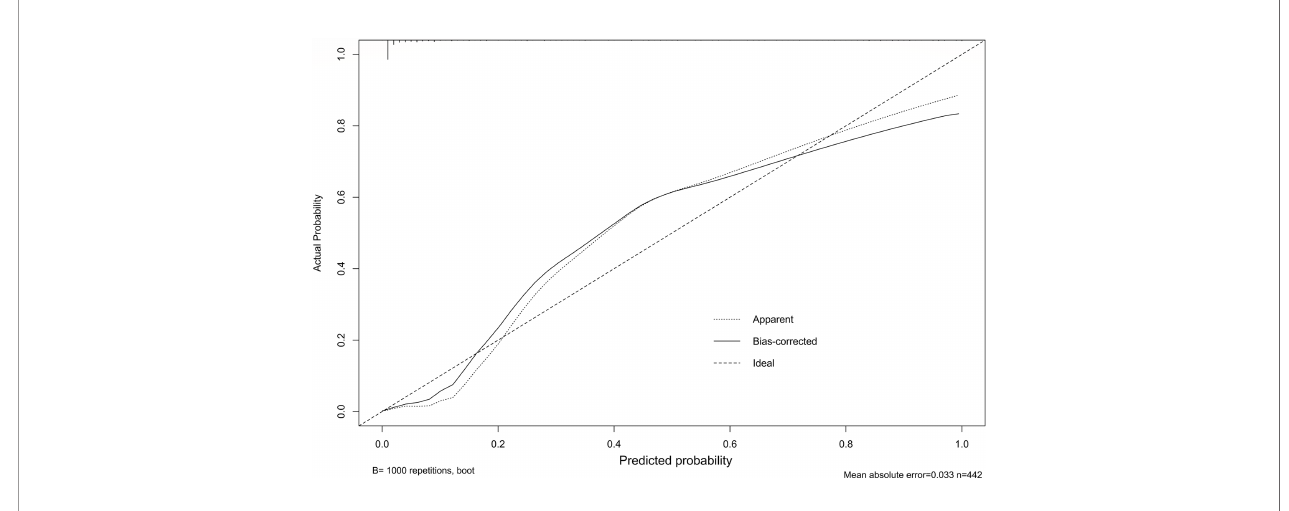
FIGURE 4 | Nomogram prediction model is evaluated by calibration